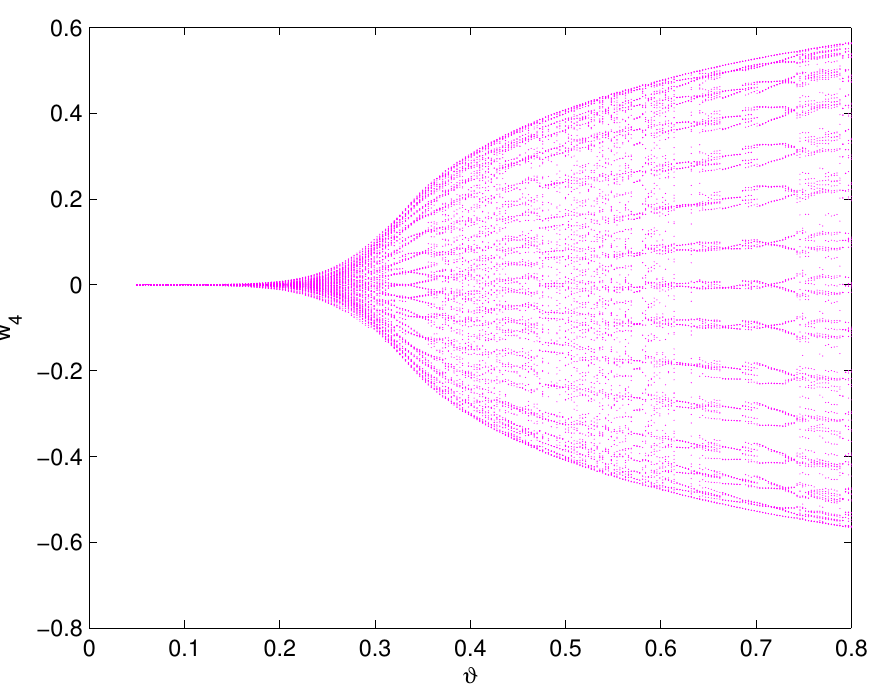
Figure 20. Bifurcation graph of system (73): the time delay ϑ versus the variable w 4 . The bifurcation number is 0.32.